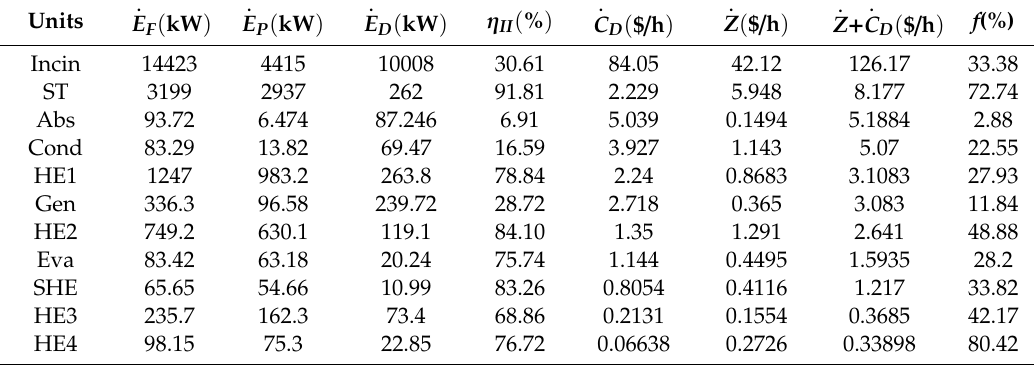
Table 5. Thermodynamic and economic main parameters of the proposed waste-fired CCHP system components.